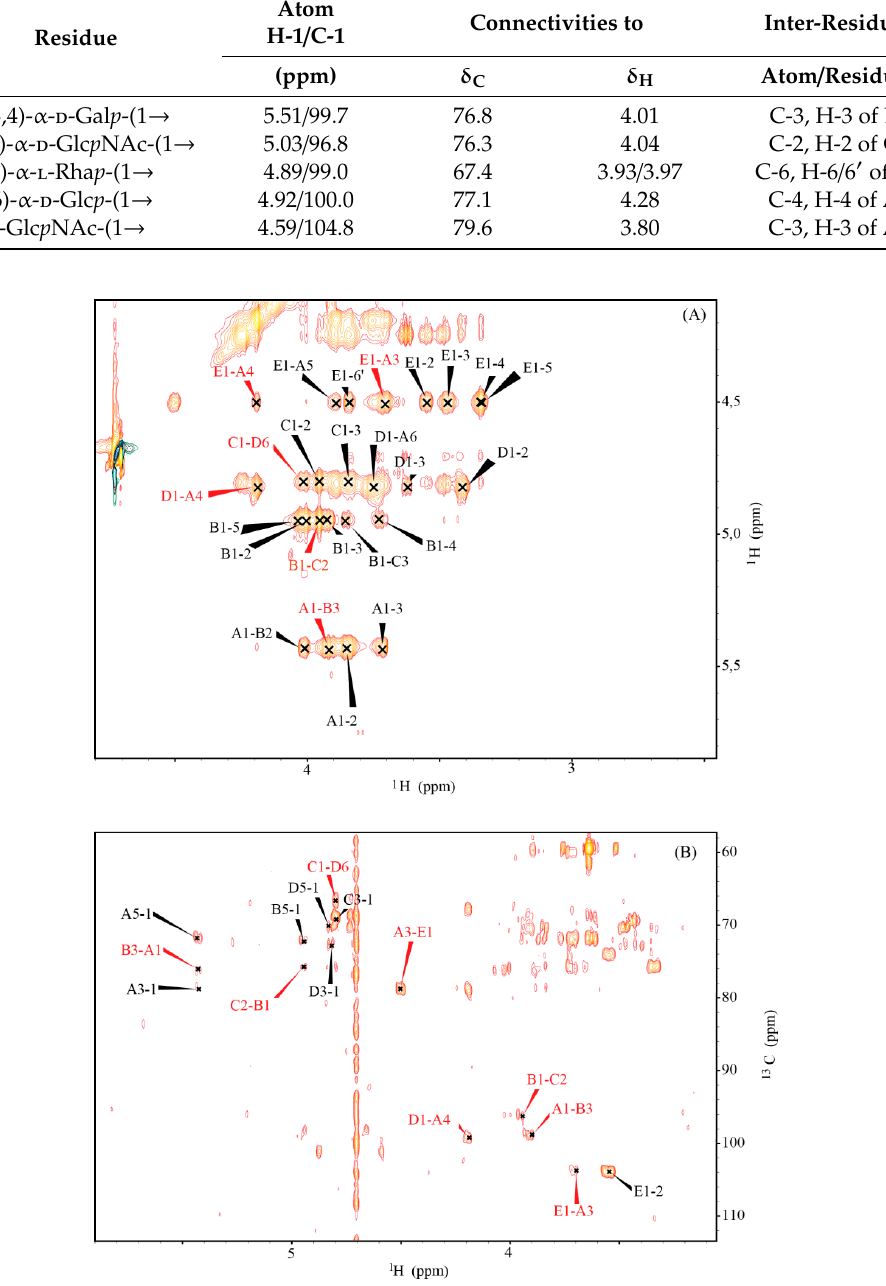
Figure 4. Part of the 1 H, 1 H NOESY spectrum ( A ) and selected 3 J H,C —connectivities in the 1 H, 13